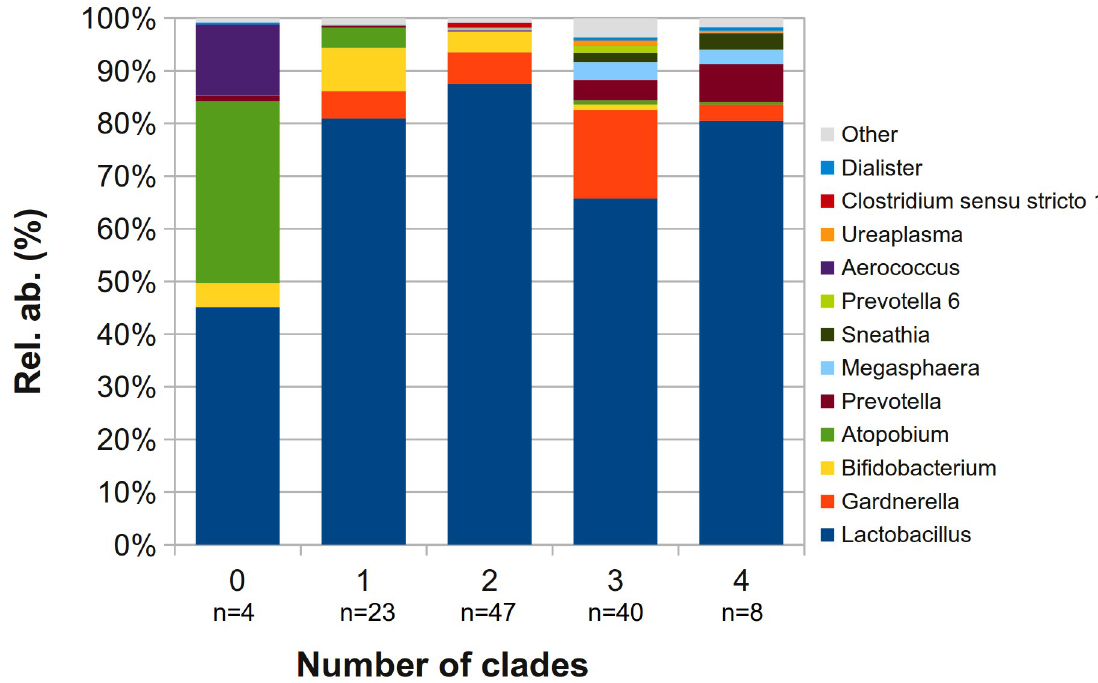
Fig 2. Barplot of the average relative abundance of the main genera, over the number of clades found at the same time in each sample. Only the first 12 most abundant genera are plotted, whereas the remaining genera are grouped in the ‘Others’ category.